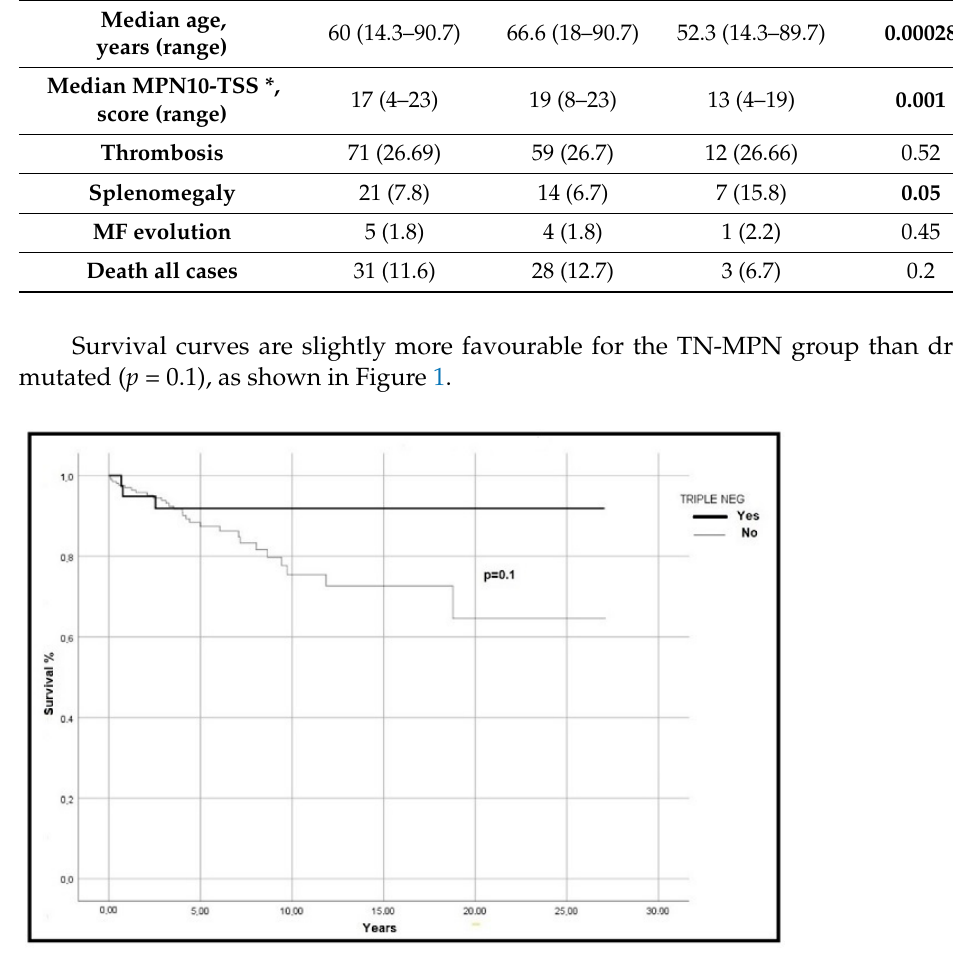
Figure 1. Overall survival in 266 ET patients. The difference between the TN and the driver-gene mutated patients is significant with a p -value of